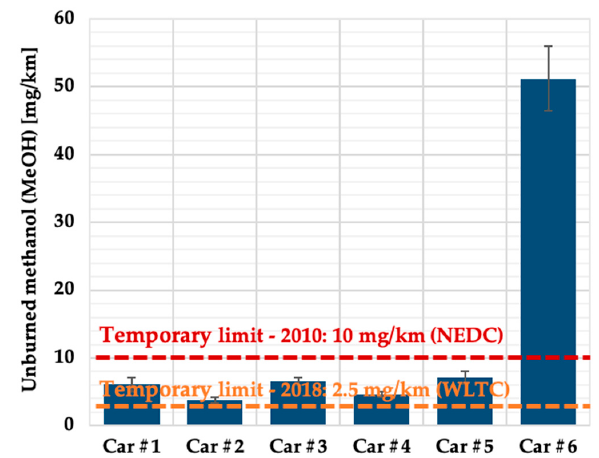
Figure 8. Unburned methanol emissions from the in-use methanol taxis.